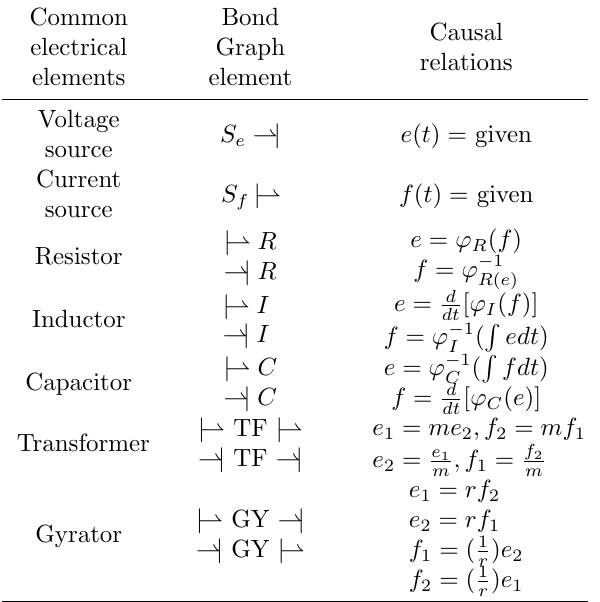
Table 3: Common electrical elements and their proper Bond Graph indicators and causal relations Common